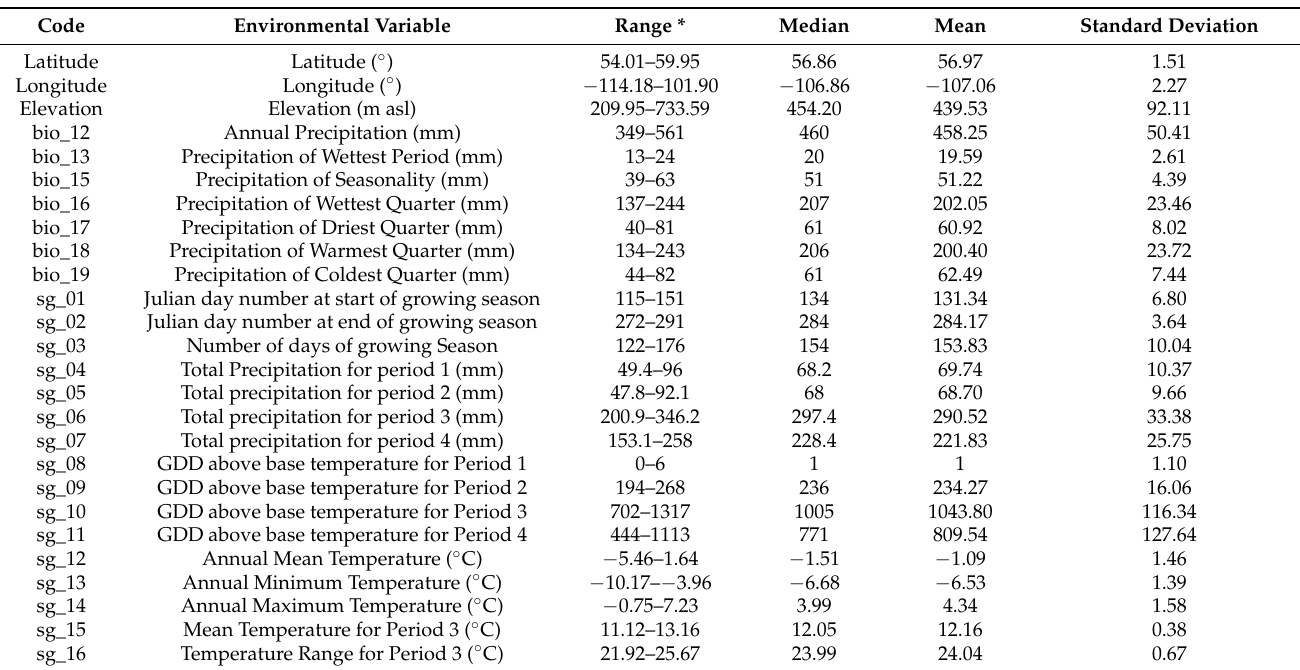
Table 2. List of location and bioclimatic variables (n = 26) and their associated summary